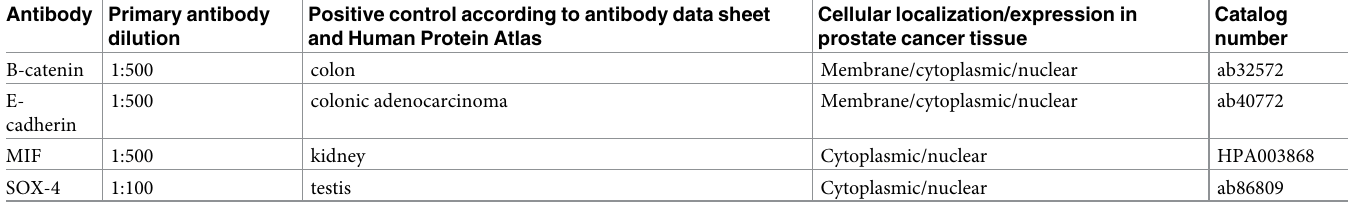
Table 2. Primary antibody